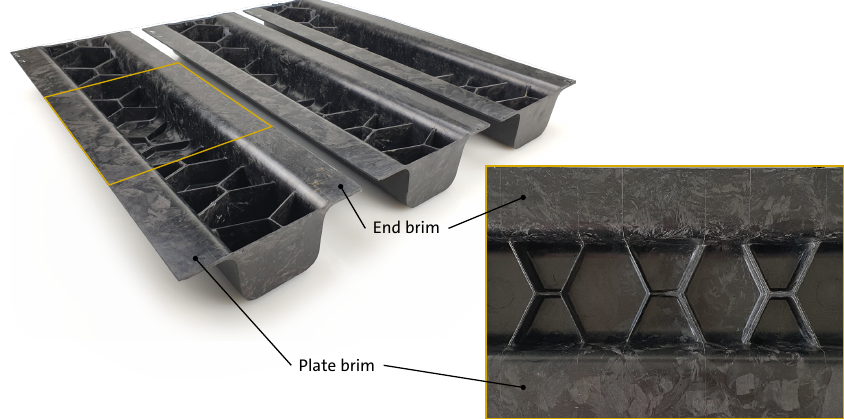
Figure 13. Three compression molded ribbed structures made of HexMC (plate areas are removed from the ribbed hat profiles) picked for CT scanning and a detailed view on the right hand side showing the middle section of sample #19 in bottom view.